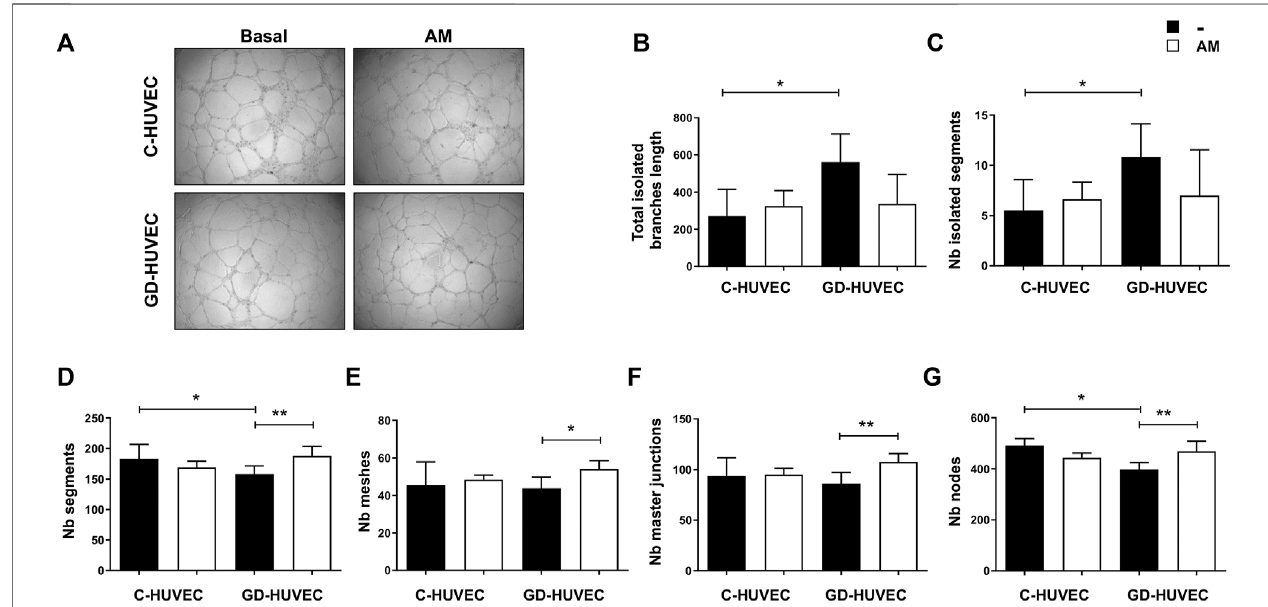
FIGURE5| EffectofAMontube-likestructure formationcapacity onMatrigel. (A) RepresentativeimagesofC-and GD-HUVECs forbothexperimentalconditions. (B – G) Different angiogenic parameters analyzed in C- and GD-HUVECs under basal conditions and after 6 h of AM incubation. Each value is expressed as mean ± SD using three different cellular strains for C-HUVECs and three different cellular strains for GD-HUVECs ( n = 3). ANOVA and Tukey ’ s multiple comparison test: * p < 0.05, ** p < 0.01.